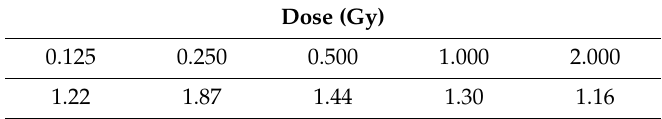
Table 2. Ratio of the mean number of foci measured at di ff erent dose points (HDR / LDR). Dose (Gy) neutrons. Red dots indicate γ -H2AX foci, while the nuclei are stained blue with a fluorescent DNA stain, namely 4 ′ ,6-diamidino-2-phenylindole (DAPI).